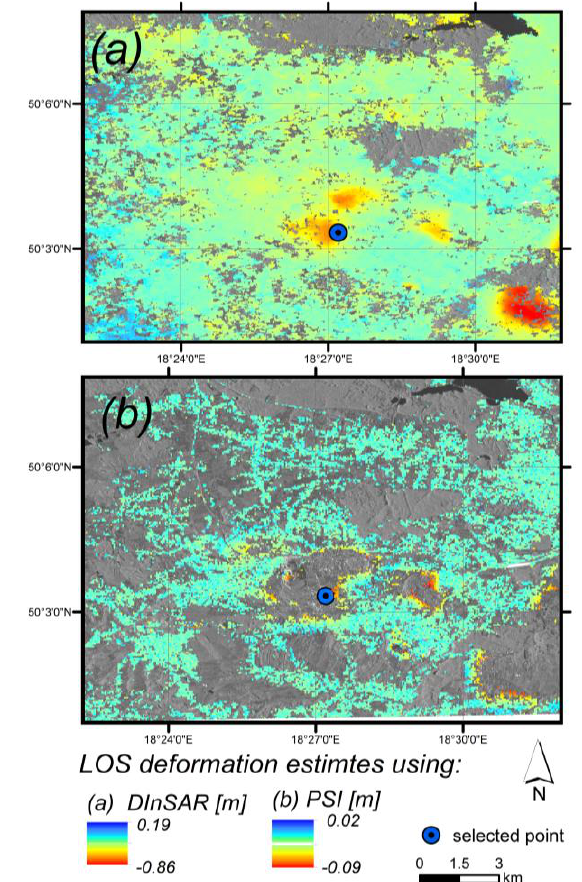
Figure 5. Deformation estimated for the time span 12.03.2018- 13.03.2019 using DInSAR (a) and PSI processing (b)